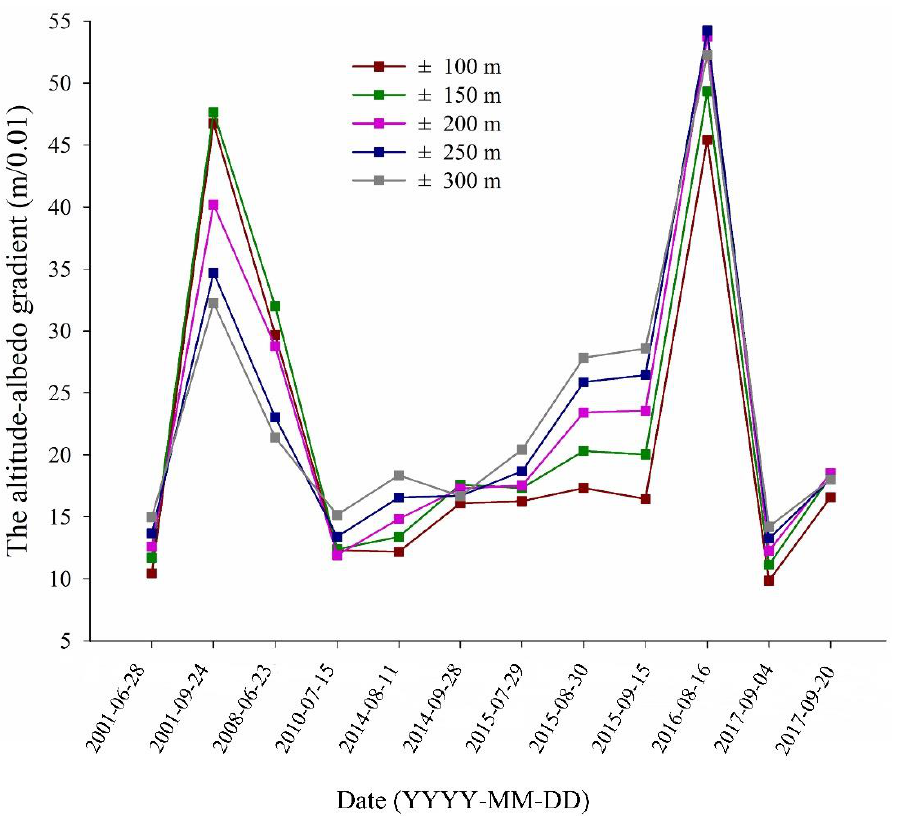
Figure 9. The altitude – albedo gradient with different altitudinal ranges in the Chhota Shigri glacier.